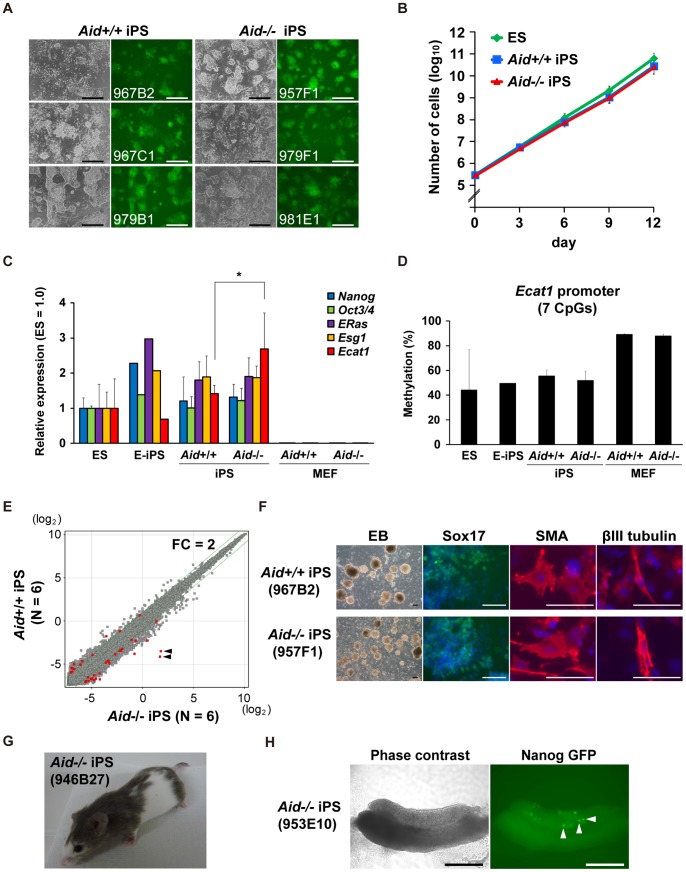
Characterization of the Aid
−/− iPS cells.(A) The morphology of the Aid
+/+ and Aid
−/− iPS cells cultured on gelatin-coated dishes (passage 6). Phase contrast (left column) and GFP fluorescence (right column) images are shown. Scale bars; 200 μm. (B) The proliferation of the cells. Three clones of ES cells, Aid
+/+ iPS cells and Aid
−/− iPS cells were passaged every three days (3×105 cells per well of a 6-well plate) on feeder-coated dishes. (C) The relative expression of pluripotent stem cell marker genes. Total RNA was isolated from three ES cell clones, two E-iPS cell clones (20D17 and 178B5), nine Aid
+/+ iPS cell clones, nine Aid
−/− iPS cell clones and three clones each of parental Aid
+/+ and Aid
−/− MEFs. The data were normalized to the level of Gapdh. The average of the ES cell clones was set at a relative level of 1 (*, corrected p-value <0.05). (D) The DNA methylation level of the Ecat1 promoter detected by pyrosequencing. (E) Scatter plots showing a comparison of the global gene expression between Aid
+/+ and Aid
−/− iPS cells. The red dots indicate differentially expressed probes (corrected p-value <0.05). Green lines indicate two-fold changes. The two most significant probes (arrowheads) were located at the 3′ UTR of Aid and detected immature Aid mRNA in Aid
−/− iPS cells, which should be driven by the inserted promoter in the drug resistance cassette. (F) The differentiation of Aid
−/− iPS cells in vitro. Differentiated Aid
−/− iPS cells were stained with antibodies for Sox17, SMA and βIII tubulin. Bars; 100 μm. (G) A chimeric mouse established with Aid
−/− iPS cells. Black hair indicates the contribution of the iPS cells. (H) Gonads isolated from 13.5 d.p.c chimeric embryos. GFP-positive cells (arrowheads) indicate the differentiation of Aid
−/− iPS cells into PGCs. Bars; 200 μm.